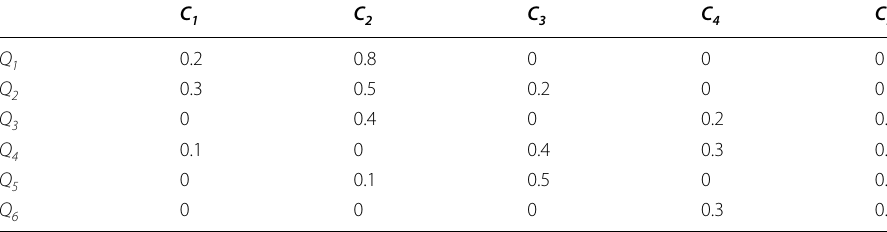
Table 2 Sample of weighted relationships of questions and